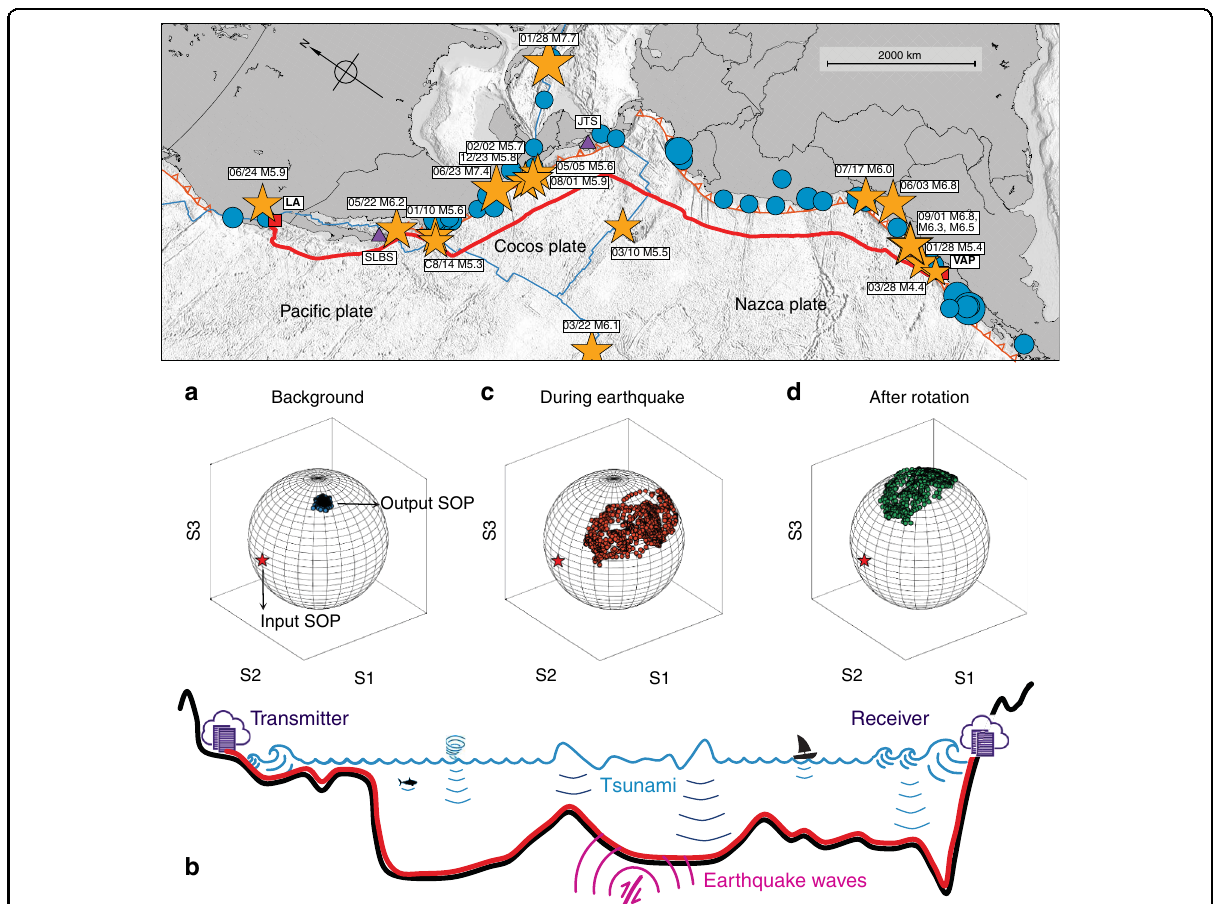
Fig. 12 Ocean monitoring performed by exploiting the long sensing distance characteristic of optical fi ber sensing. a The state of polarization (SOP) at the receiver is monitored routinely (blue dots on the Poincaré sphere) while the input SOP stays stable (red star). For the Curie cable, the output SOP is robust, owing to relatively minimal perturbations along most of its path in the deep ocean ( b ). The robustness allows us to detect earthquakes or ocean waves that produce SOP anomalies by shaking or pressuring the cable ( c ). Because the three Stokes parameters are normalized to 1.0, only two are independent. In this study, we rotate the Stokes parameters to the north pole of the Poincaré sphere (9) and focus on analyzing the S1 and S2 parameters after rotation ( d